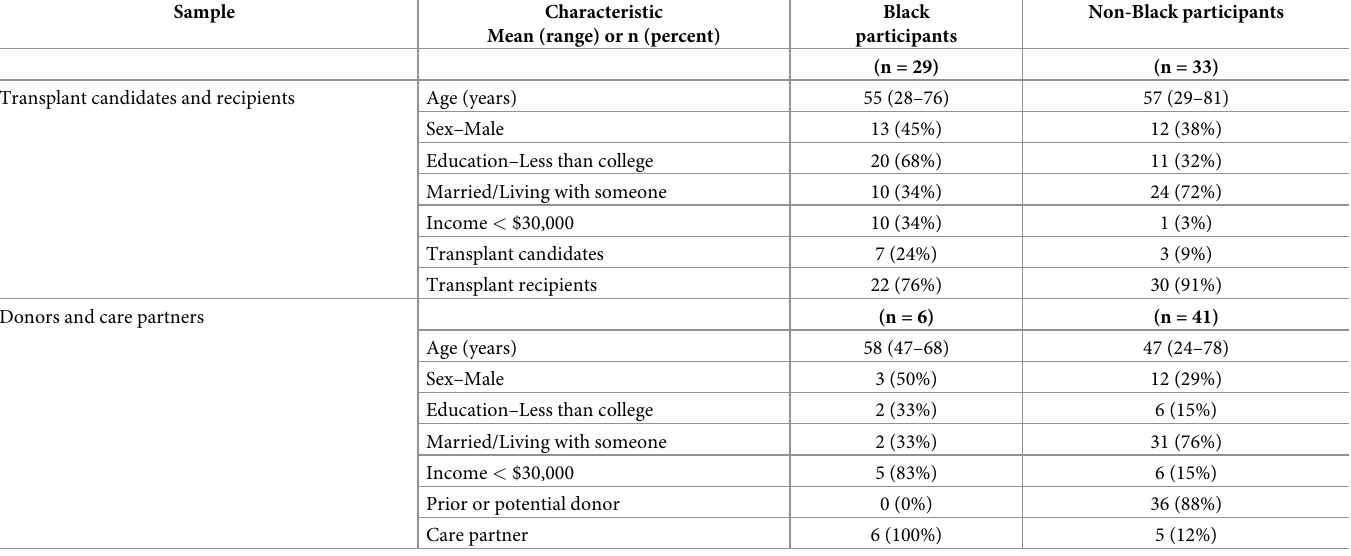
Table 1. Participant characteristics.